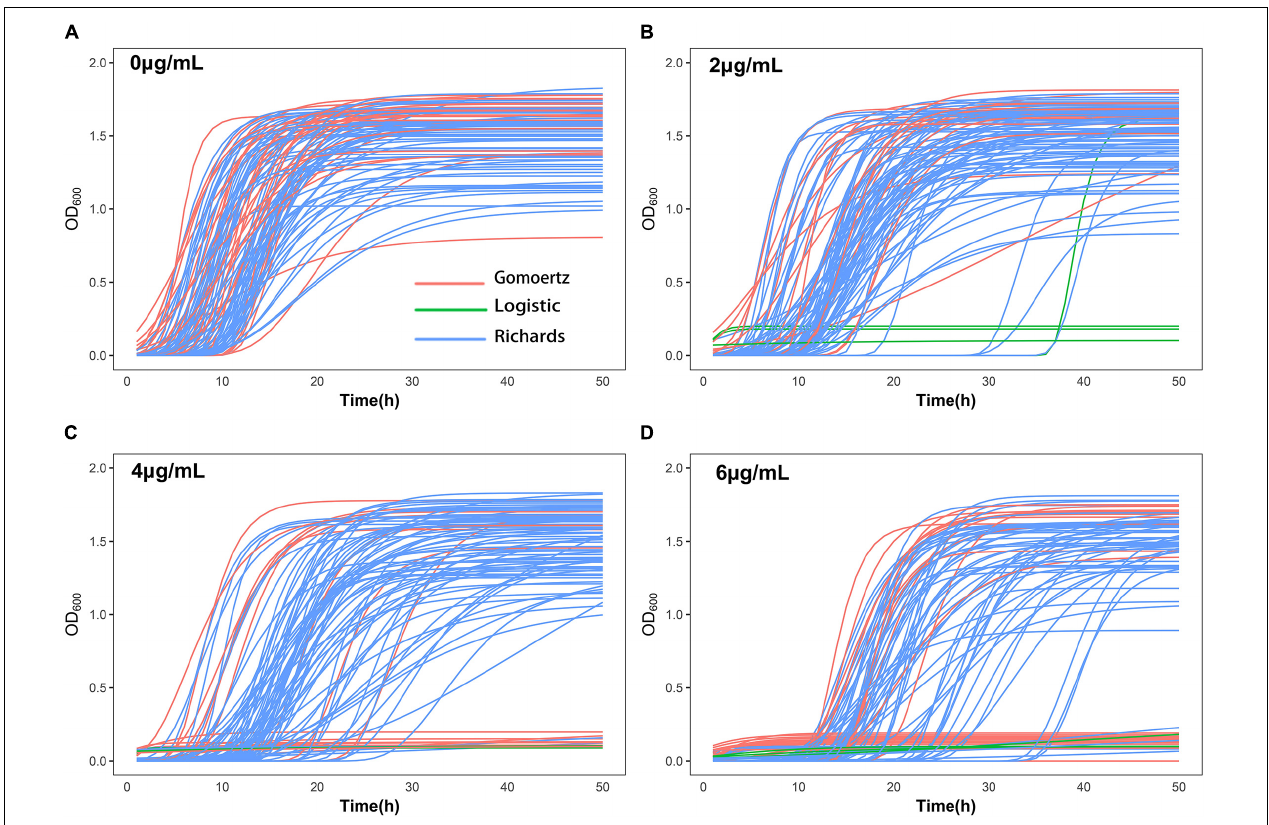
FIGURE 1 | Growth curve fitting of 99 S. aureus strains. The growth curves of all strains at 0 µ g/mL (A) , 2 µ g/mL (B) , 4 µ g/mL (C) , and 6 µ g/mL (D) vancomycin treatment were fitted by Gompertz, Logistic or Richards equation. Each line represents the growth of a strain, red represents Gompertz equation, blue represents Richards equation, and green represents Logistic